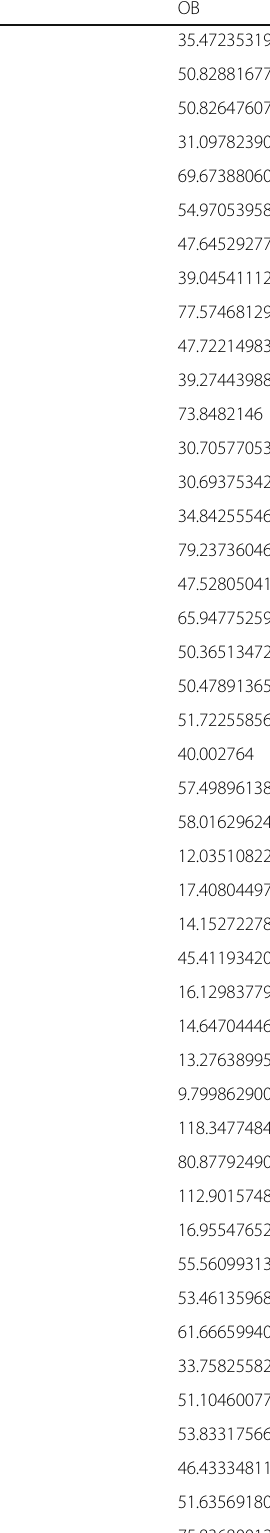
Table 1 Ninety bioactive compounds filtered through the ADME system in